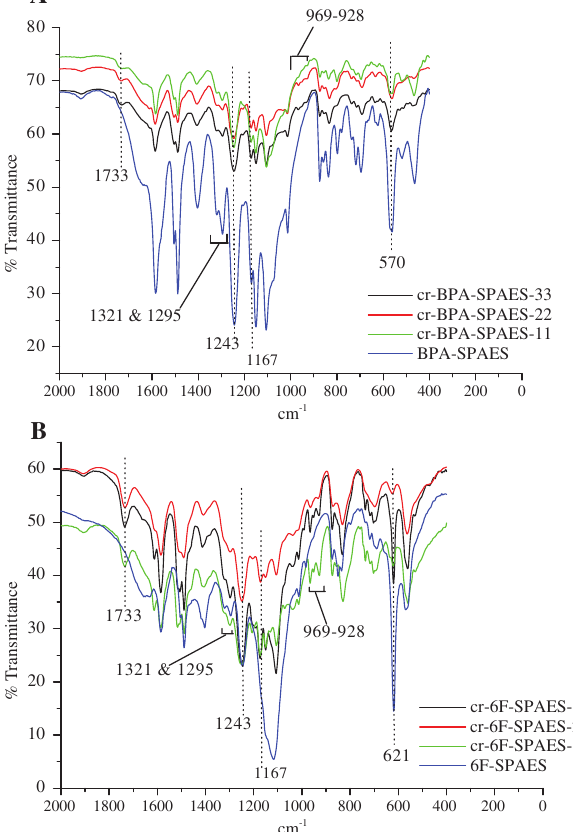
Figure 3: FTIR spectra of (A) BPA-SPAES and its crosslinked membranes and (B) 6F-SPAES and its crosslinked membranes,